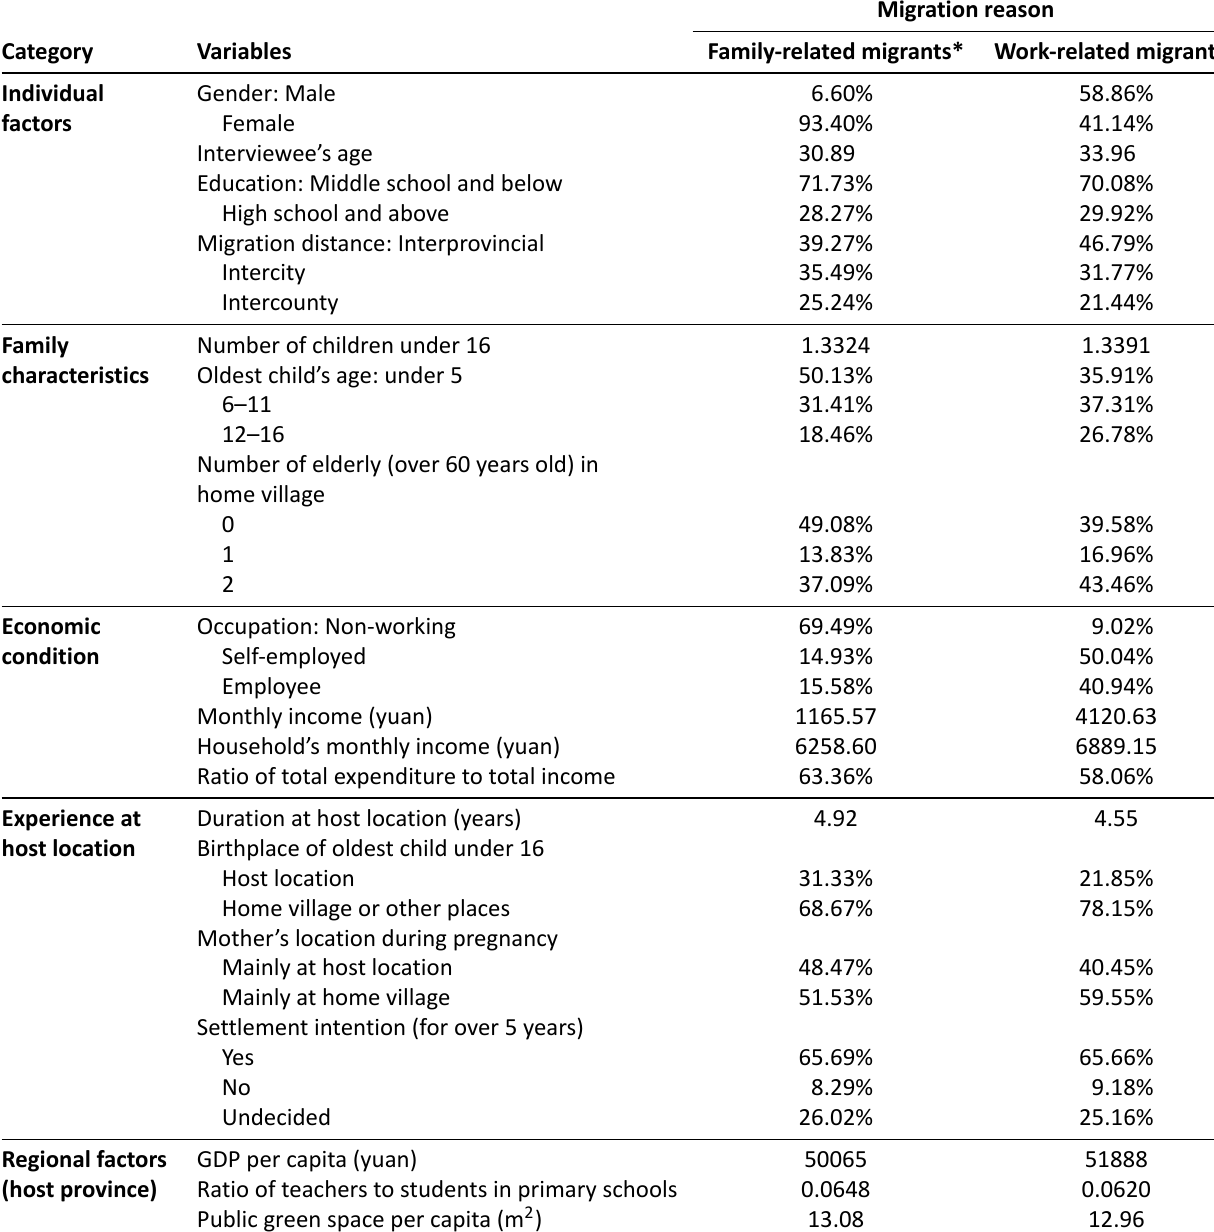
Table 1. Migrants by migration